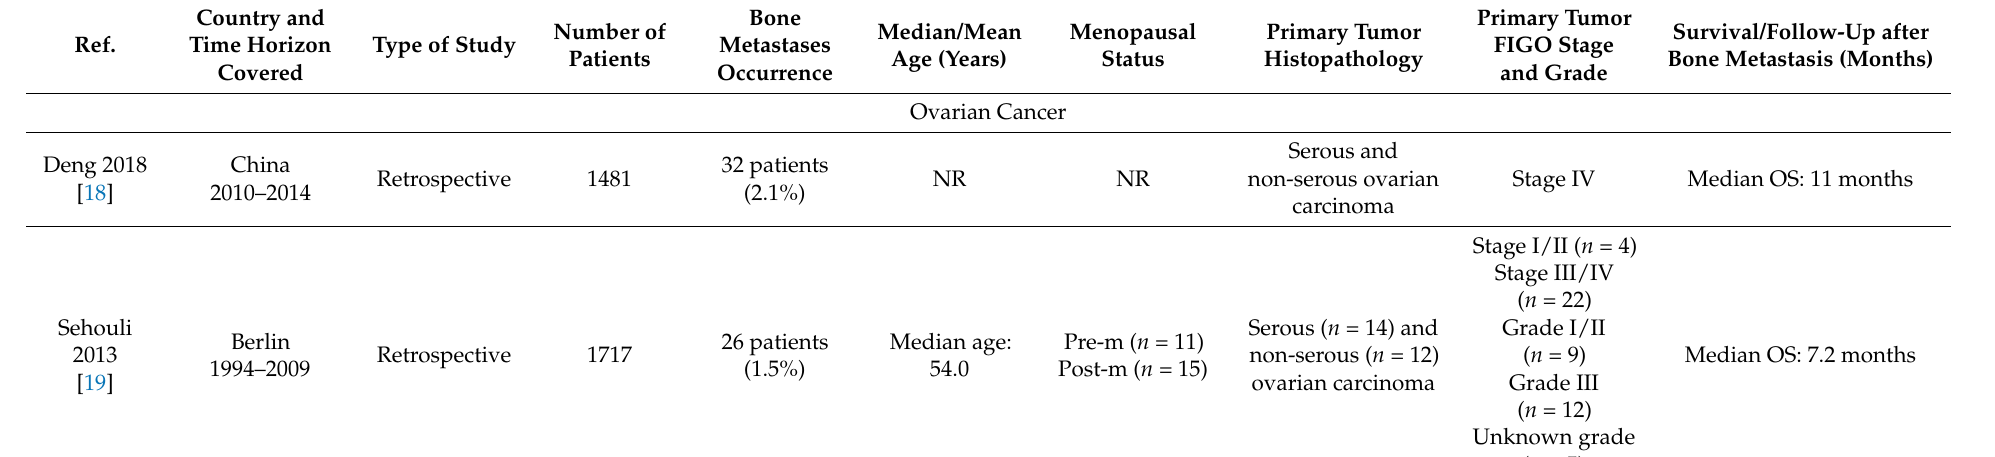
Table 2. Characteristics of patients at time of diagnosis of GC bone metastasis in the included studies.